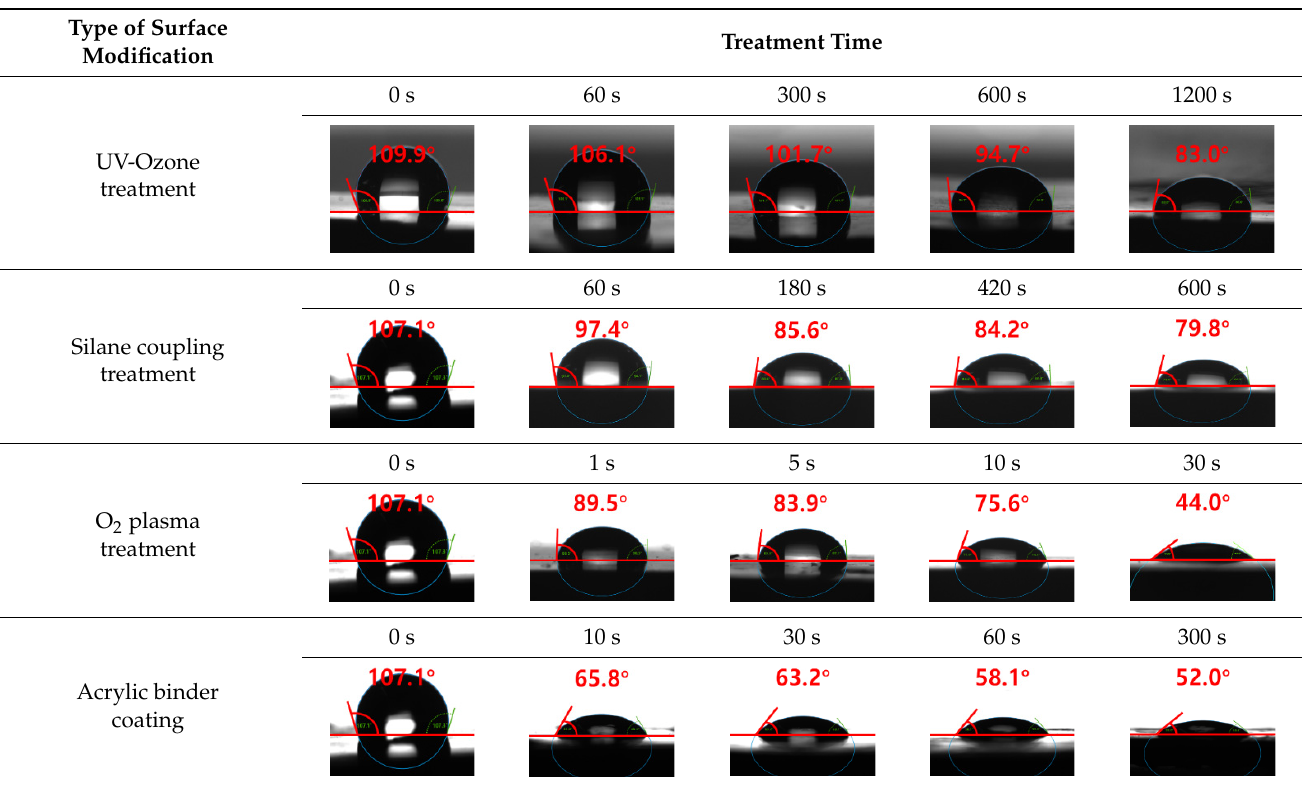
Figure 6. Contact angle change as a function of surface modification types and time for the recycled plastic film-based aggregates. Table 1. Contact angle measured on the recycled plastic film-based aggregates as a function of surface modification types and time.